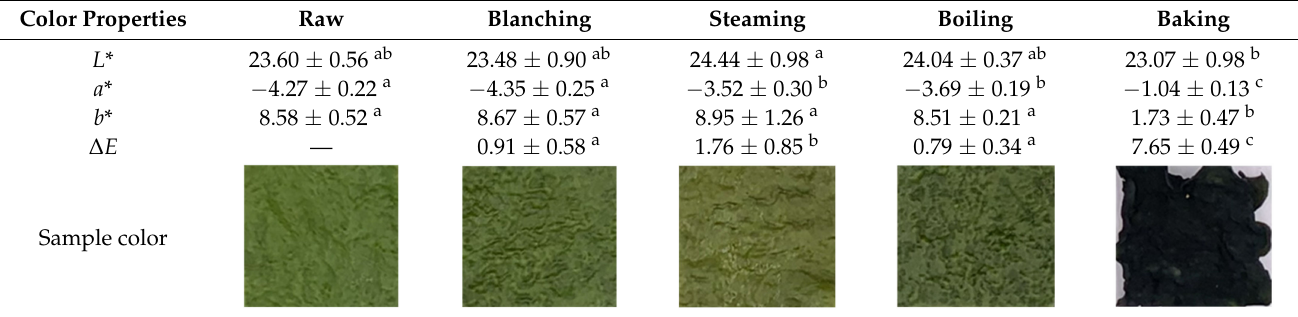
Table 1. Influence of different cooking methods on the color of Undaria pinnatifida ( U. pinnatifida